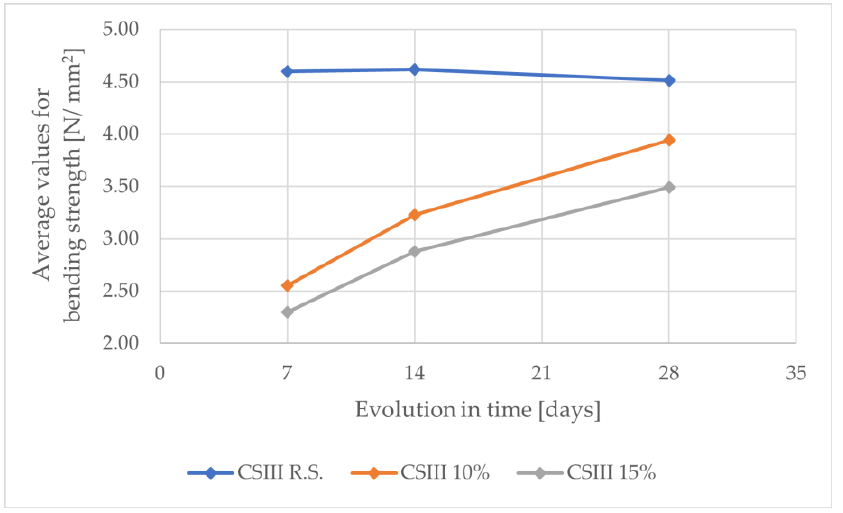
Figure 15. Bending strength results.